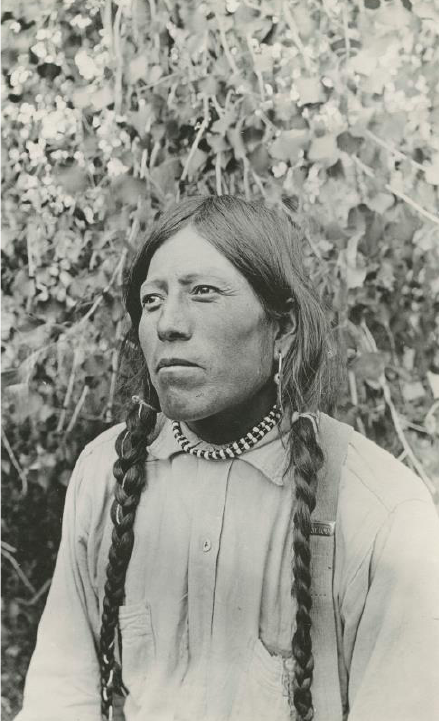
Figure 5. Judd Neil, “Crescencio Martinez, San Ildefonso Pueblo, New Mexico”, 1910. Courtesy of the Palace of the Governors Photo Archives (NMHM/DCA), 031234.